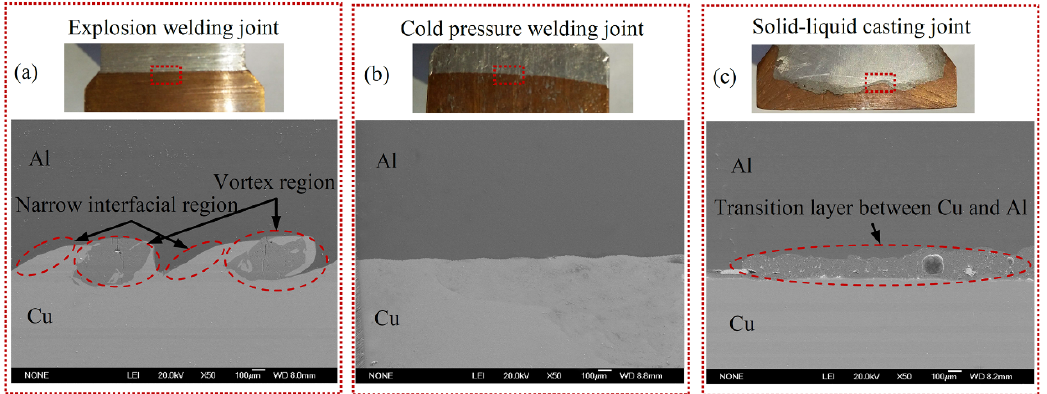
Figure 1. The interface macro-appearance and micro-morphologies of three kinds of interface structures, shown as: ( a ) explosion welding joint, ( b ) cold pressure welding joint and ( c ) solid-liquid casting joint.